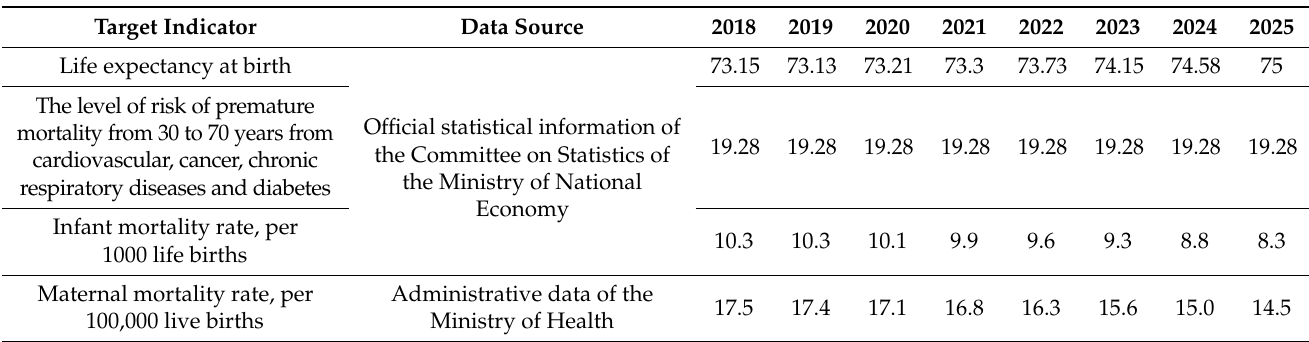
Table 1. Target indicators for life expectancy and infant and maternal mortality outcomes for the years 2018 to 2025. Target Indicator Data